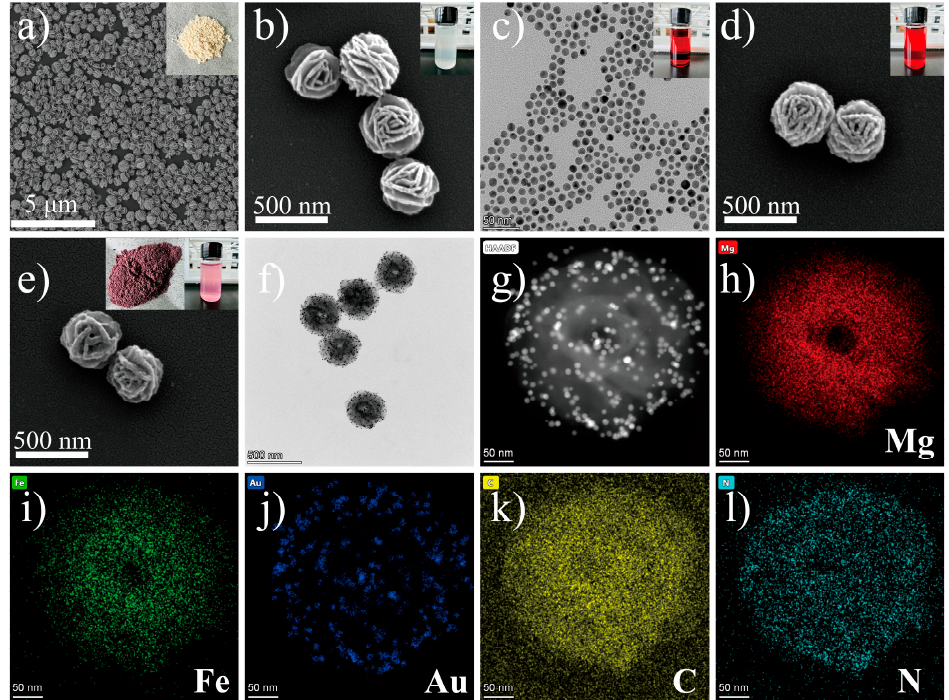
Figure 2. ( a , b ) SEM and TEM images of Mg/Fe LDH NFs. (The two insets are MF NFs solid powder and the state dispersed in H 2 O.) ( c ) OLM capped Au NPs. (The inset is the state dispersed in CHCl 3 .) ( d ) SEM images of MF@Au NFs. (The inset is the state dispersed in CHCl 3. ) ( e , f ) SEM and TEM images of MF@Au@PEI NFs. (The two insets are the MF@Au@PEI solid powder and the state dispersed in H 2 O.) ( g – l ) HAADF STEM image and EDS mapping images of MF@Au@PEI NFs.